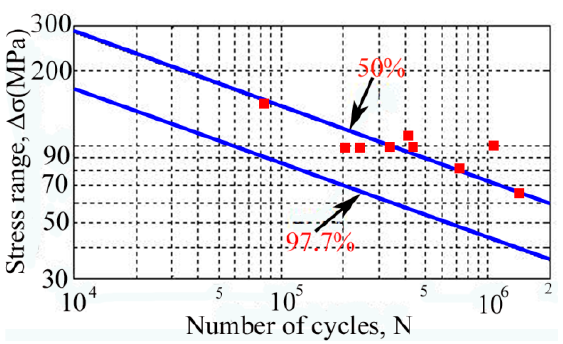
Figure 10. Δσ -N curves of fatigue specimens.